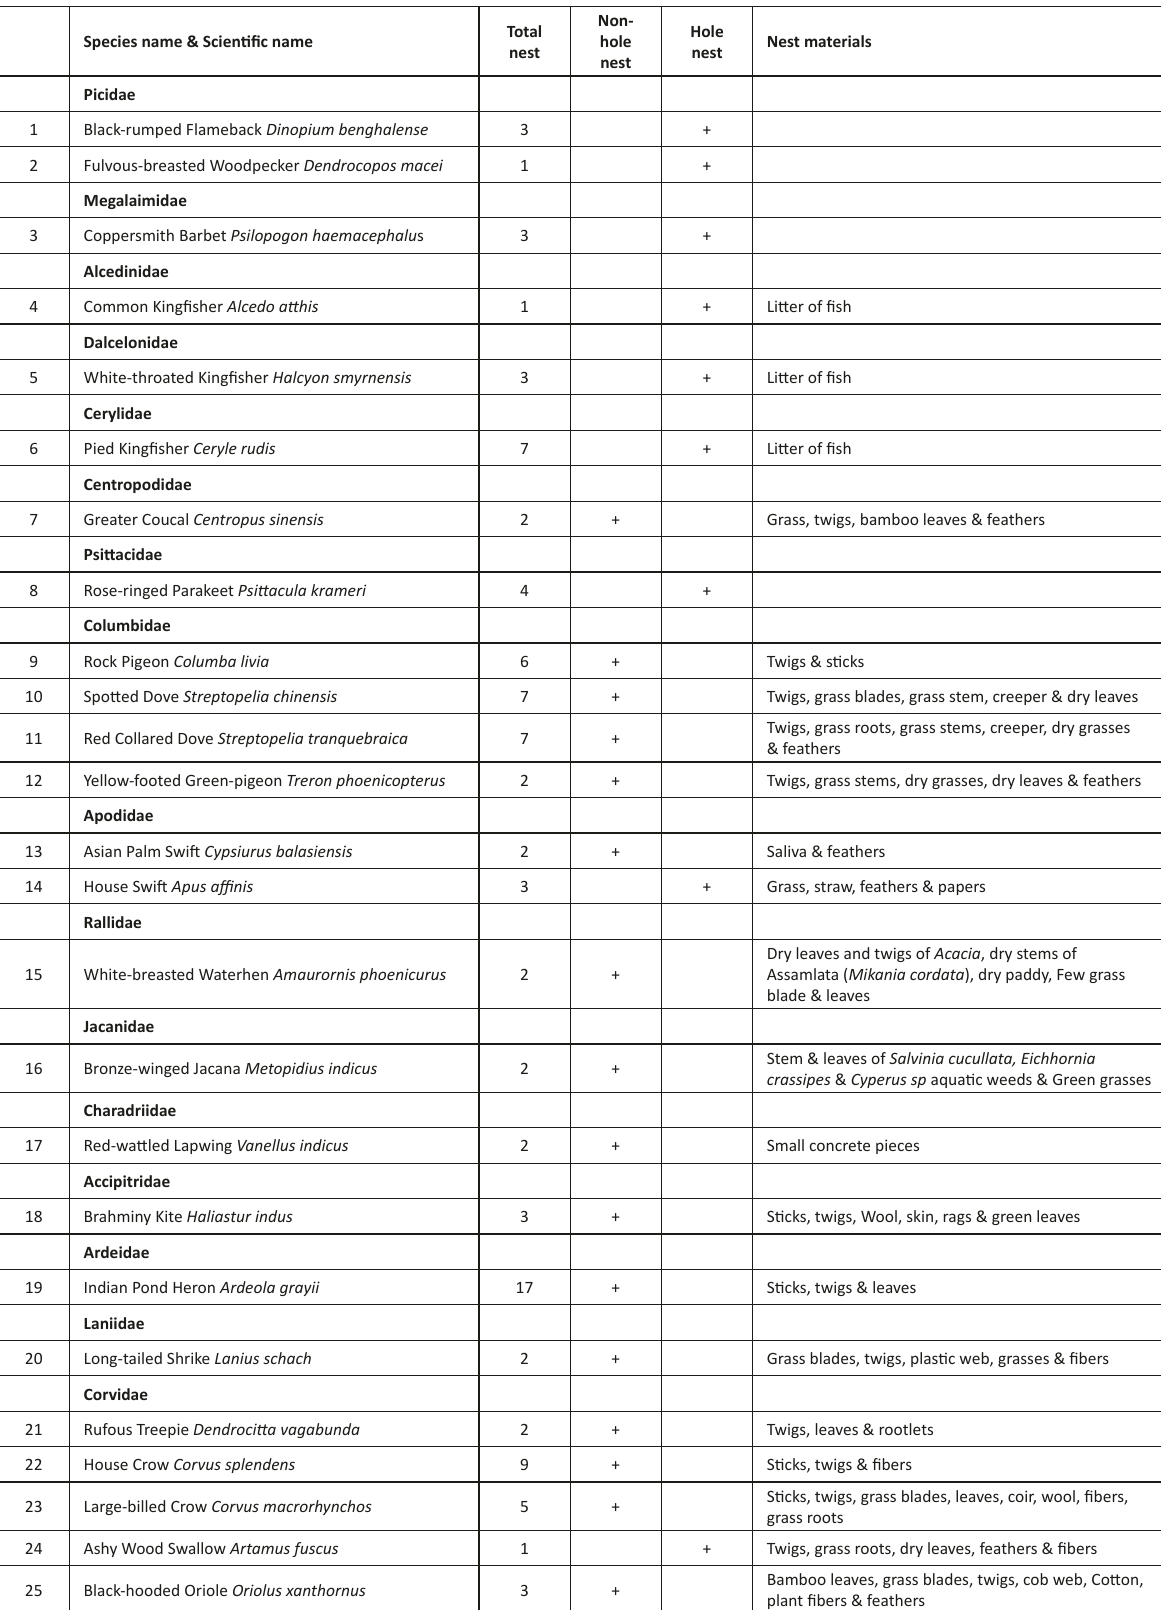
Table 3. List of nesting birds observed in Jahangirnagar University campus and their nest